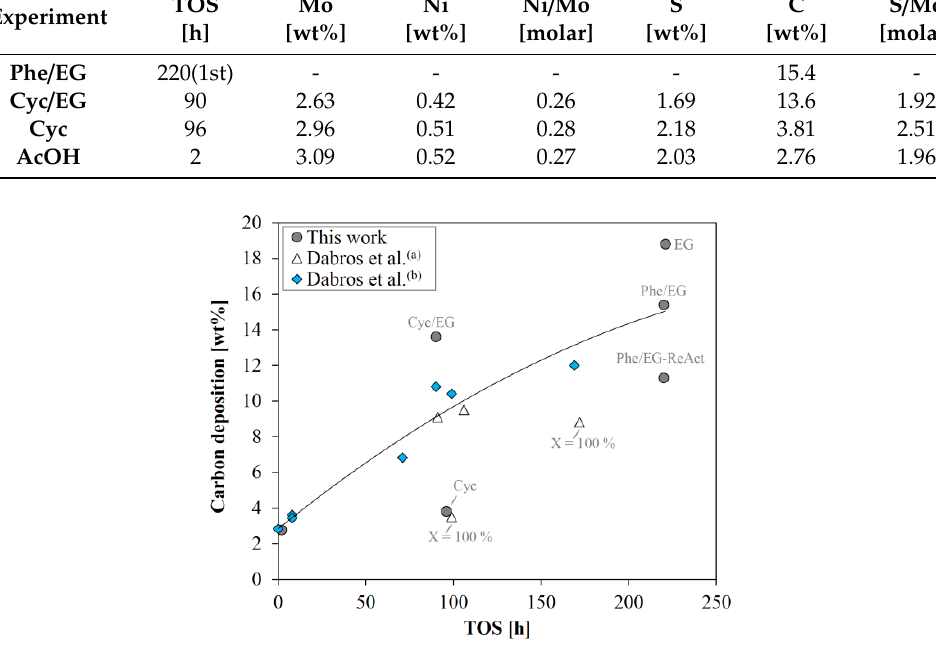
Figure 8. Carbon deposition as a function of time on stream. From HDO tests performed at 380–450 °C. Data from this work (Table 2 and Table 5, circles: text denotes experiment name), Dabros et al. (a) [18] (Table 3, triangles, X = 100 % denotes experiments with full conversion), and Dabros et al. (b) [19] (Table 2, diamonds).